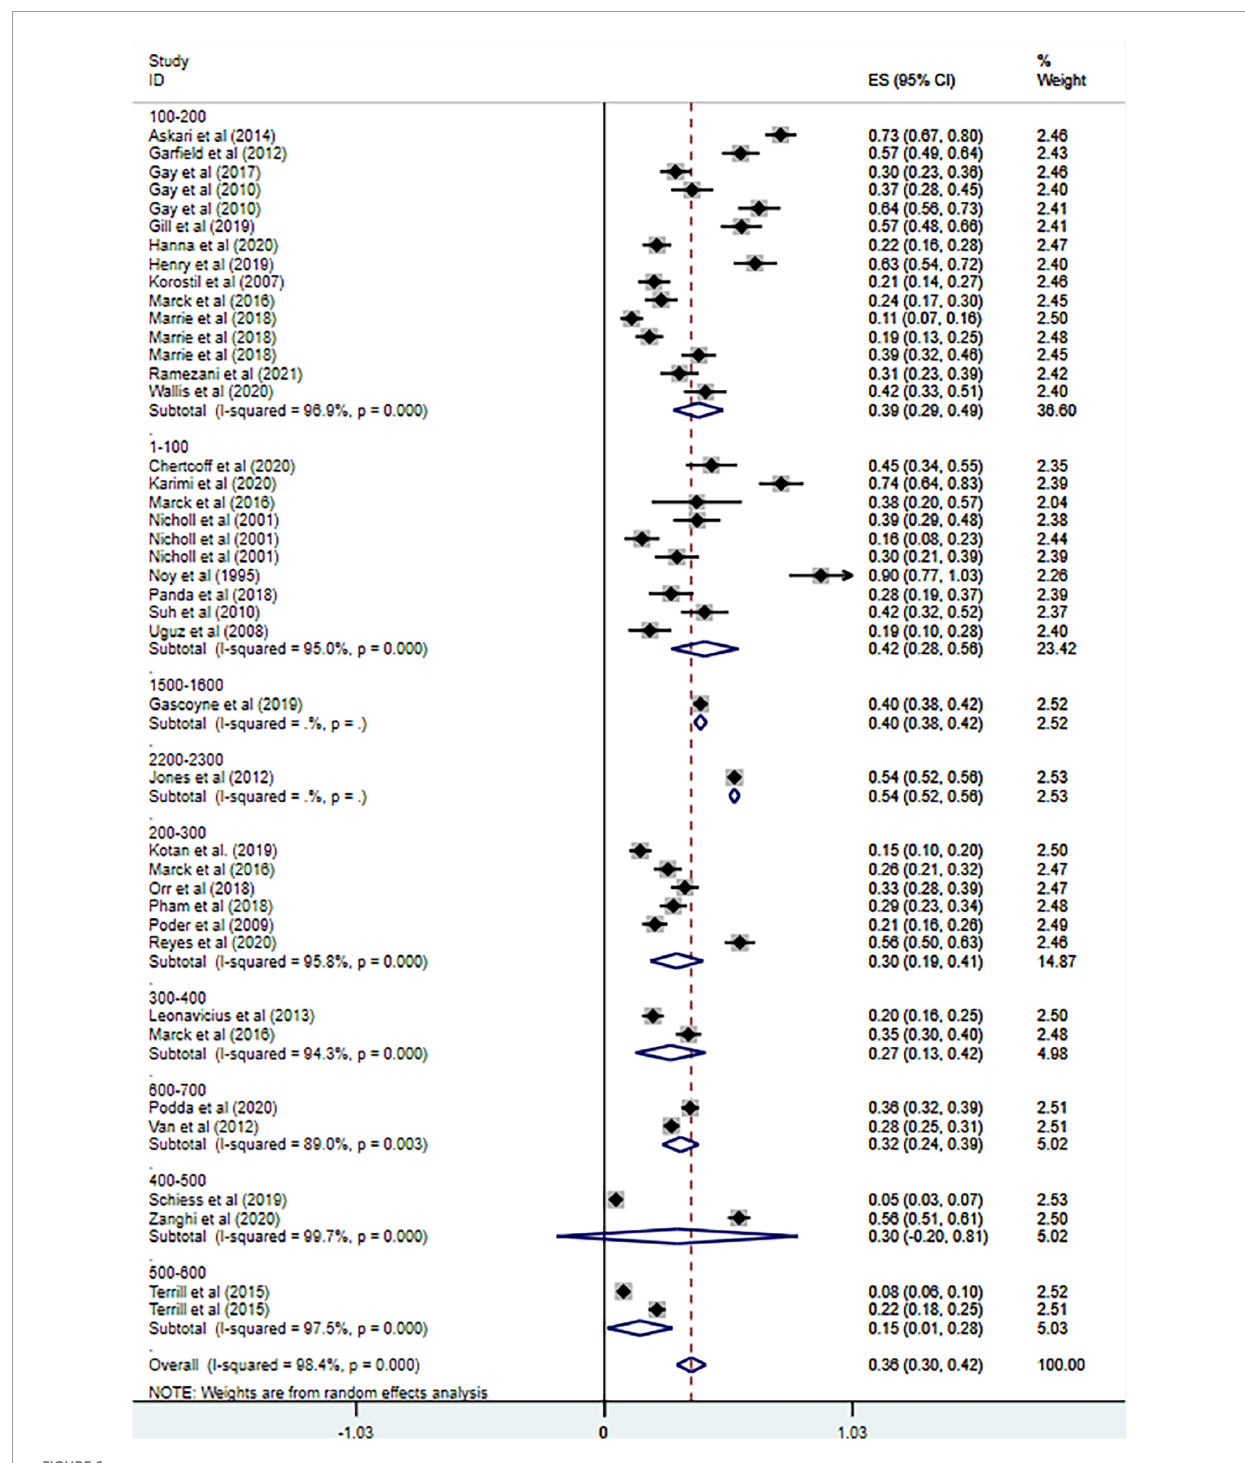
FIGURE6 Forest plot of subgroup analysis on changes of prevalence of anxiety in MS based on total sample size.